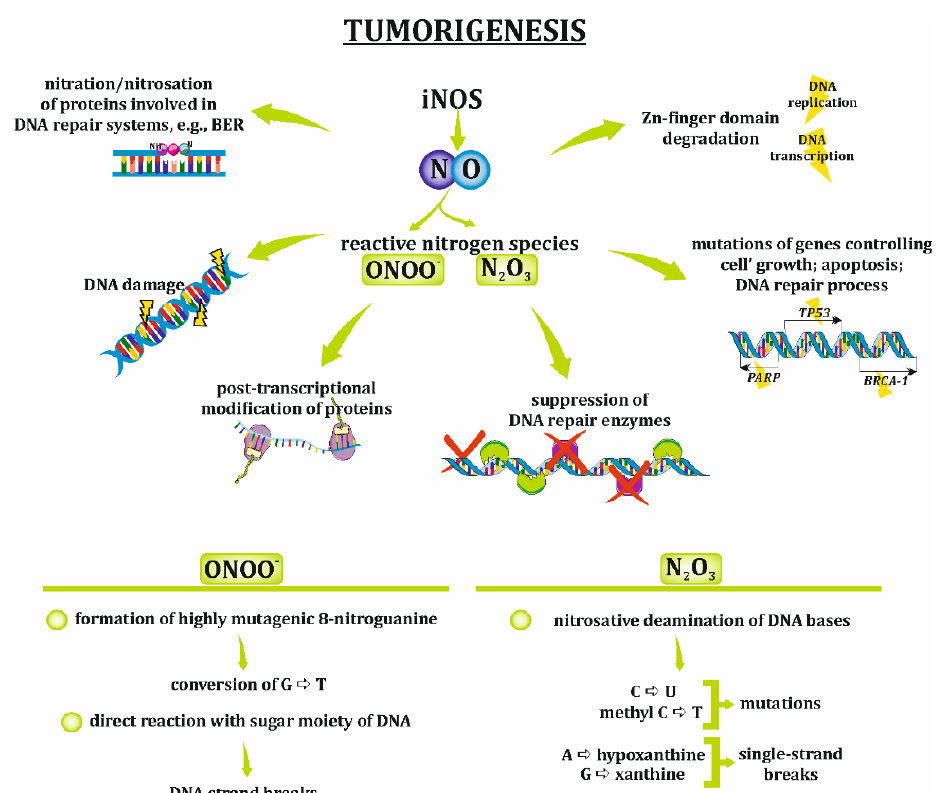
Figure 3. Role of NO and reactive nitrogen species in tumorigenesis. Although the role of iNOS has never been directly determined in carcinogenesis, the activity of its product—nitric oxide (NO)—and NO’s derivatives, such as peroxynitrite (ONOO − ) or dinitrogen trioxide (N 2 O 3 ), influence normal cells causing their transformation and inducing tumorigenesis. BER, base extinction repair system; G, guanine; A, adenosine; C, cytosine; U, uracil; T, thymidine.